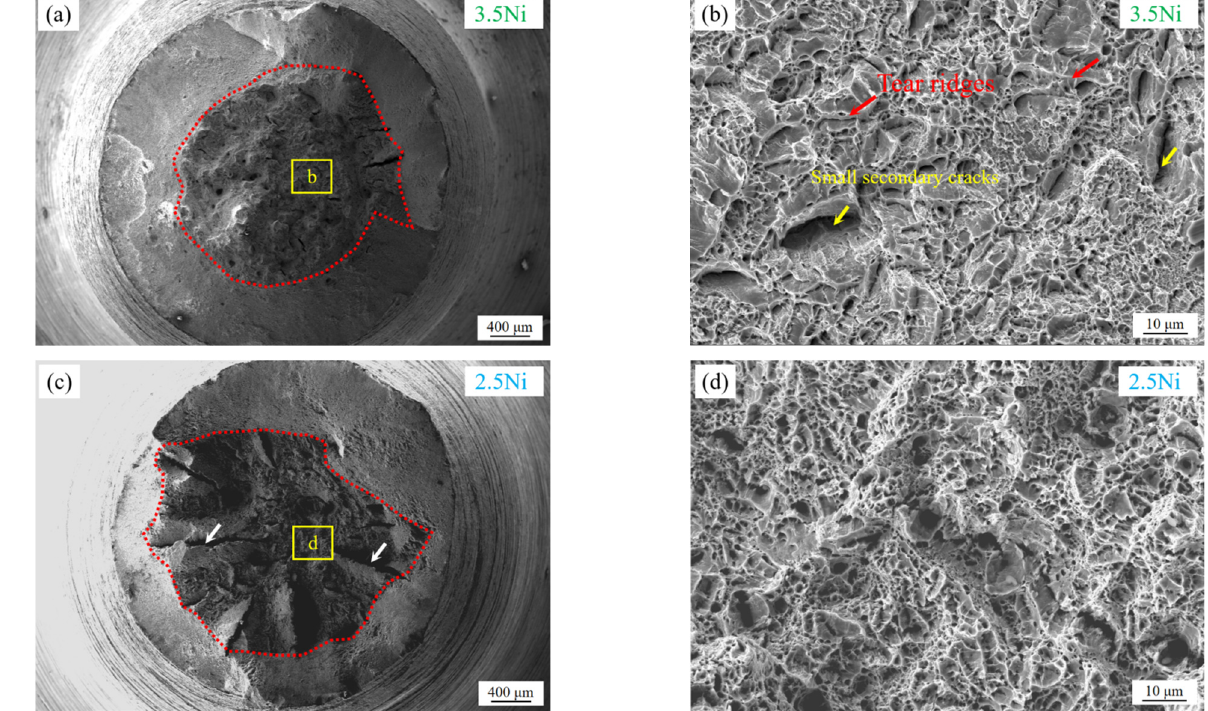
Figure 19. ( a , c ) SEM morphologies for the fracture surface in the hydrogen-charging specimens. ( b , d ) high magnification image of selected region.